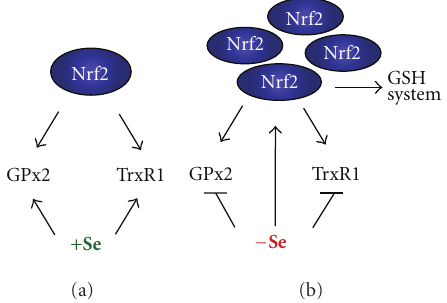
Figure 1: Interplay between Nrf2 and the selenoproteins thiore- doxin reductase-1 (TrxR1) and glutathione peroxidase-2 (GPx2). (a) In the presence of selenium, the activation of Nrf2 leads to increased mRNA of both enzymes which can be translated into respective proteins. (b) Under selenium deficiency, Nrf2 is activated which in principle can lead to an induction of TrxR1 and GPx2 mRNA. Due to lack of selenium, the proteins cannot be synthesized. Decrease in TrxR1 further activates Nrf2, which subsequently upregulates enzymes of the glutathione (GSH) system. These, in part at least, can compensate the reduced TrxR1 activity. For details see